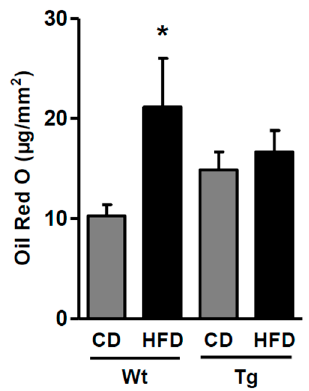
Figure 4. Lipid accumulation quantified by Oil Red O (ORO) staining in the aortas from control (Wt) and transgenic (Tg) mice fed the control diet (CD) or the high-fat diet (HFD). * p < 0.05 vs. WtCD.